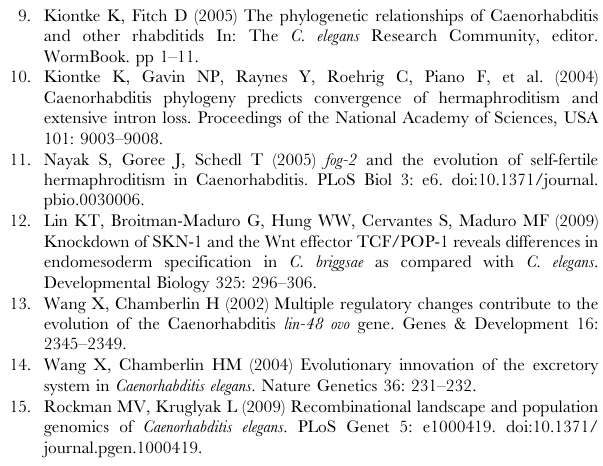
Materials and Methods). Table S2 Analysis of possible inversions. Columns contain the SNP name, cb4 chromosome assignment, and cb4 chromosome assembly position of the 132 SNPs common to the AI-RIL and F2 RIL datasets. The genetic position (in centimorgans) of each marker in the AF16/HK104 and VT847 6 AF16 genetic maps, normalized to produce linkage groups of length 50 cM, is given. Blocks of markers that are nonrecombinant in one map but recombinant in the other, consistent with the expectation of an inversion, are boxed. Blocks of markers whose genetic order is inverted relative to the other map are shaded. Table S3 Analysis of genetic-physical map discrepancies. This table contains information about the C. briggsae genome physical map (cb25 assembly FPC and supercontig data [37], shades of gray), and the genetic and physical map positions of genetic markers genotyped to produce genetic map and genome assembly versions cb3 and cb4. All cb25 assembly data for only those supercontigs affected by cb3 or cb4 genetic-physical map discrepancies are shown in columns A–I; these data are necessary to identify the positions of unsupported supercontig gaps within FPCs at which FPCs can most reasonably be split (rows where Ctg Start = ‘‘clone’’ and Ctg End =‘‘no’’). The next six columns, containing cb4 data (shades of blue), provide the cb4 assembly coordinates of the supercontigs; the names, positions, linkage group (LG) assignments, and map positions of genetic markers typed in our study, a description of the action taken to resolve discrepancies between the physical order of markers (according to the cb25 sequence assembly) and their genetic order (based on the cb4 genetic map), and the single-letter suffix assigned to split supercontigs. The same information from cb3 [38] is provided (shades of orange) for comparison. For ease of referring to supercontig splits, we have numbered the cb3 splits (‘‘cb3-1’’ to ‘‘cb3-30’’) and the cb4 splits (‘‘cb4-1’’ to ‘‘cb4-63’’). In cases where a split was introduced within a supported sequence contig, the exact position of the split is given in the ‘‘Action’’ column.